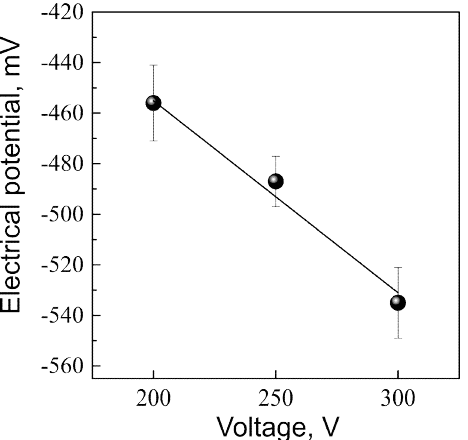
Figure 5. Graph of the electrical potential on the CaP coating surface against the applied MAO voltage.